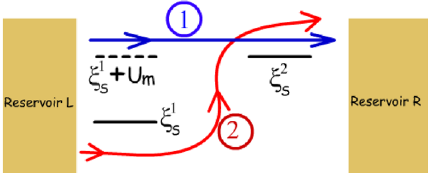
Figure 10. Schematic diagram depicting the two current components through the triple dot set-up. “Component 1” (directed blue arrow) flows without absorbing heat packets from the remote reservoir G and only depends on the occupancy probability of the ground state of G 1 . “Component 2” (directed red line) flows by absorbing heat packets from the reservoir G , and results in extraction of heat from the